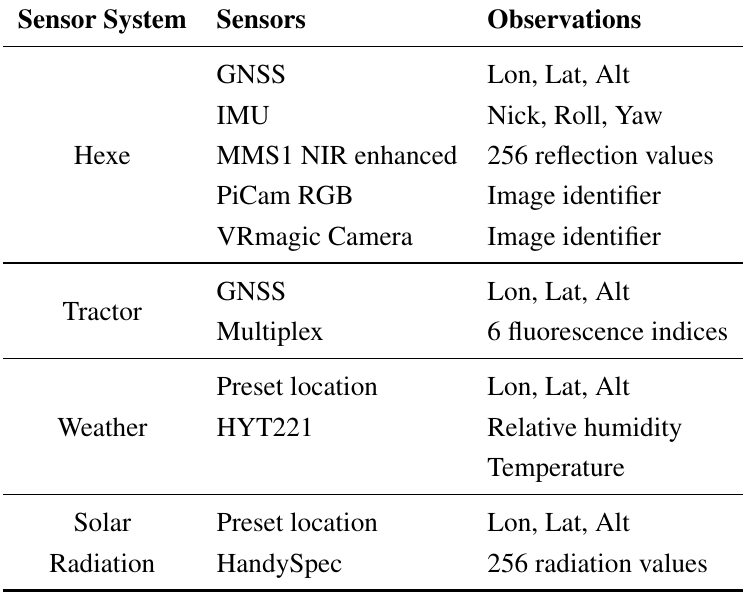
Table 1. Summary of the the sensor systems’ observations, specified in the input